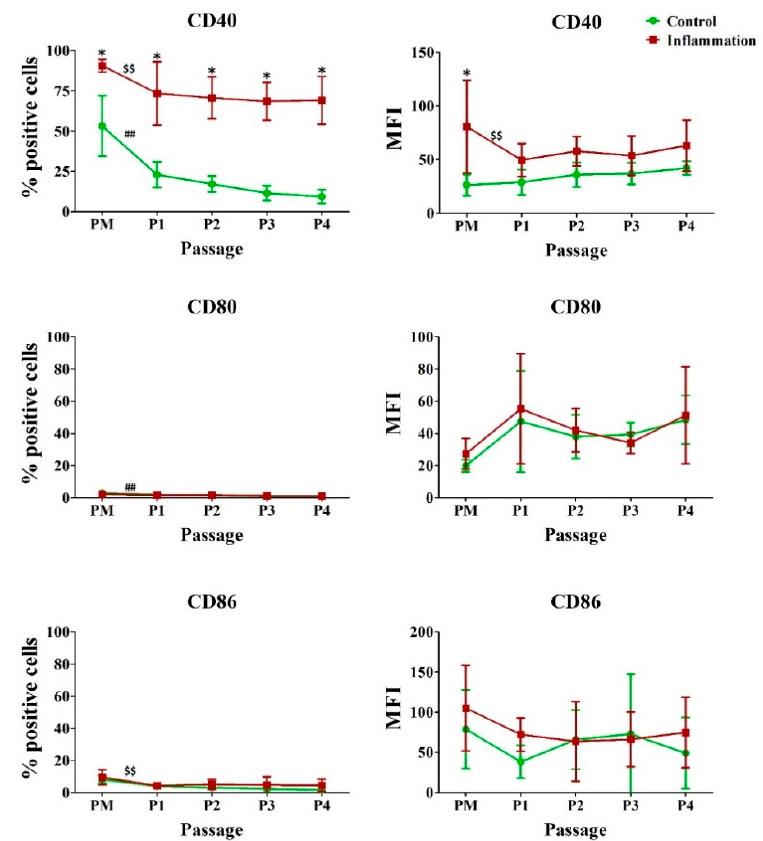
Figure 3. Impact of inflammation and cell passaging on the expression of co-stimulatory molecules in AT-MSCs. Flow cytometric analysis was used to determine the percentage of positive cells and the protein expression per cell (MFI). The values are expressed as mean ± SD and originate from six different AT-MSC donors. * Significantly higher percentage or amount per cell in inflammation-stimulated AT-MSCs compared to regular AT-MSCs ( p -value < 0.05). ## Significantly lower percentage or amount per cell in regular AT-MSCs compared to the consecutive passage ( p -value < 0.05). $$ Significantly lower percentage or amount per cell in inflammation-stimulated AT-MSCs compared to the consecutive passage ( p -value <